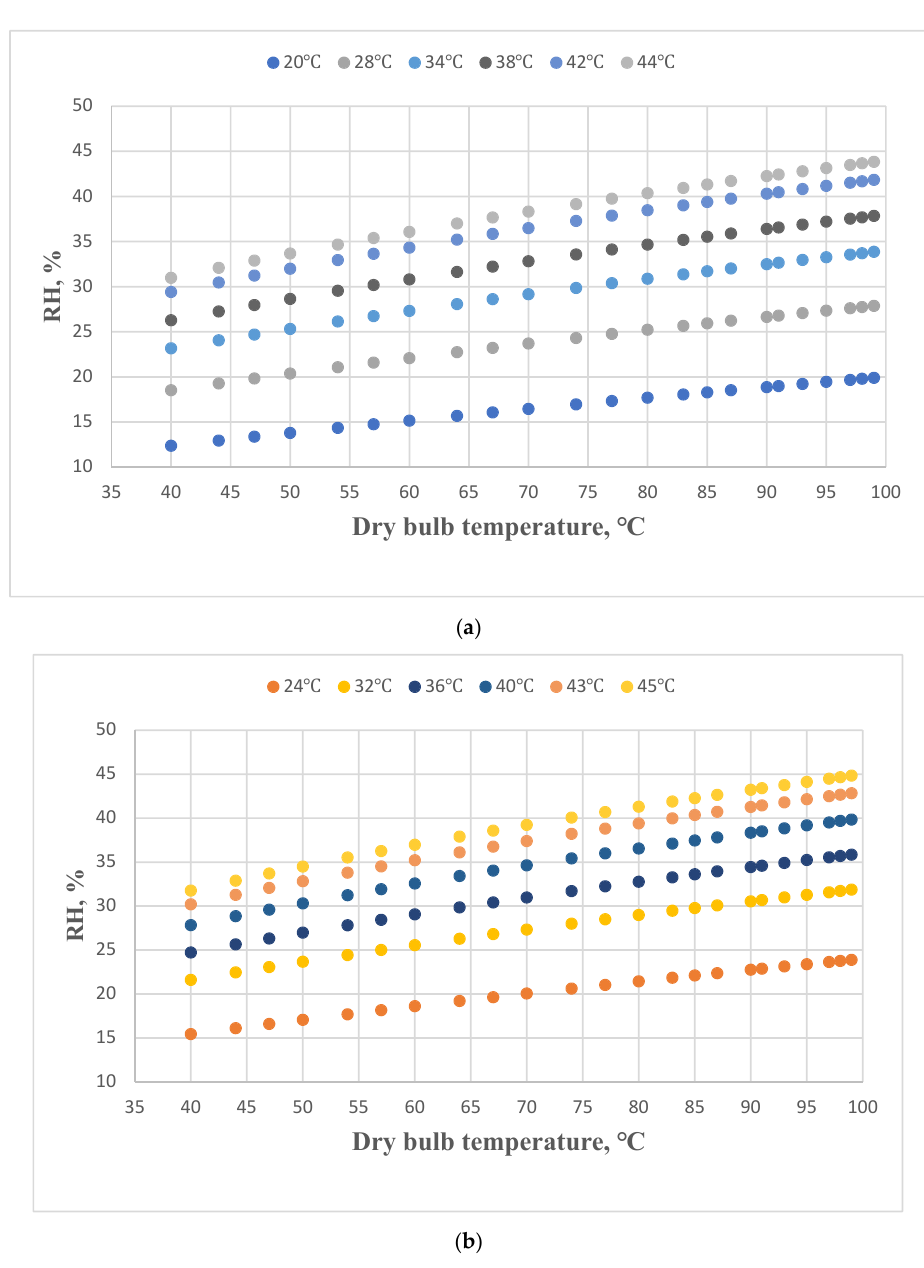
Figure 1. The distribution for Tw and RH for different Td values. ( a ) 20, 28, 34, 38, 42, 44 ◦ C, ( b ) 24, 32, 36, 40, 43, 45 ◦